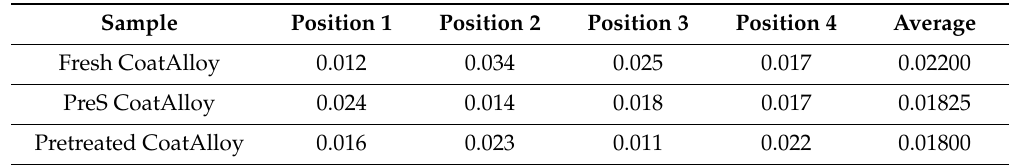
Table 6. Sulfur detection in wt% for the three CoatAlloy ™ samples: CoatAlloy ™ sample without sulfur addition, presulfided and pretreated before cracking without presulfiding. The error margin is 0.001 wt% for all measurements. Acceleration voltage: 15